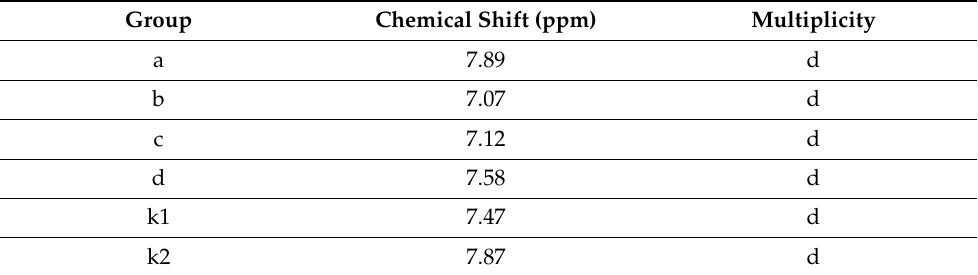
Table 4. Approximate number of units determined by NMR spectroscopy.